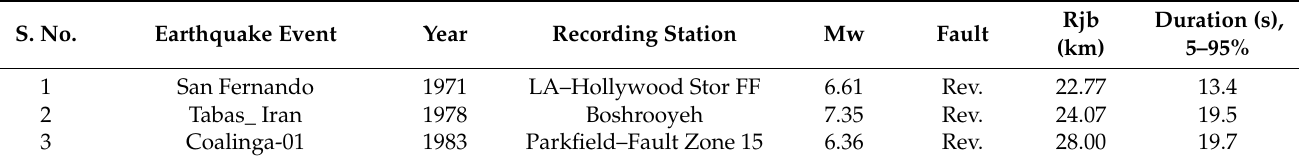
Table A1. Details of the ground motions used for nonlinear response history analysis. Rev. represents reverse faults; Rev. Ob. represents reverse and oblique faults, and SS represents strike-slip